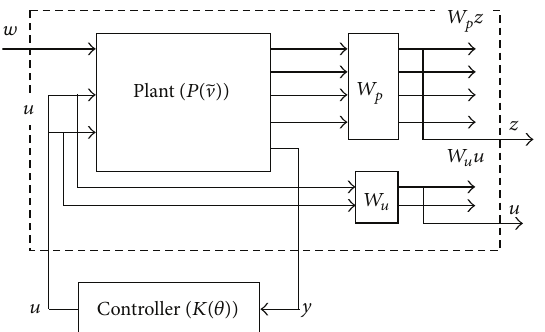
Figure 4: The lower LFT control structure with augmented plant.